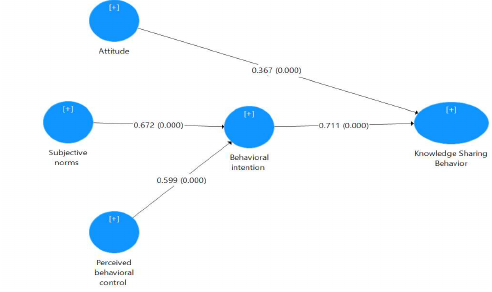
Fig. 3: Attitude impact directly Knowledge Sharing Behavior